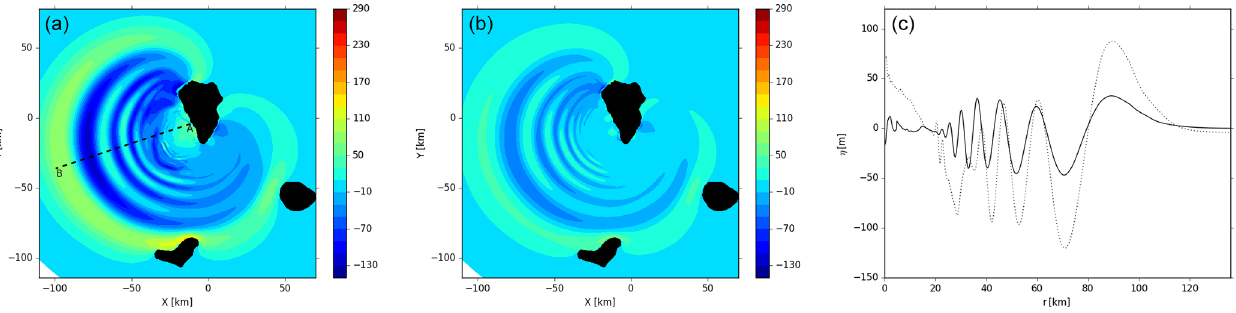
Figure 12. THETIS 3D computations for the 80km 3 slide scenario at t ≈ 560s: (a) inviscid slide, (b) slide viscosity 2 × 10 7 Pas, and (c) free surface elevations along the cross section A–B (a) . Inviscid slide: continuous line; viscous slide: dotted